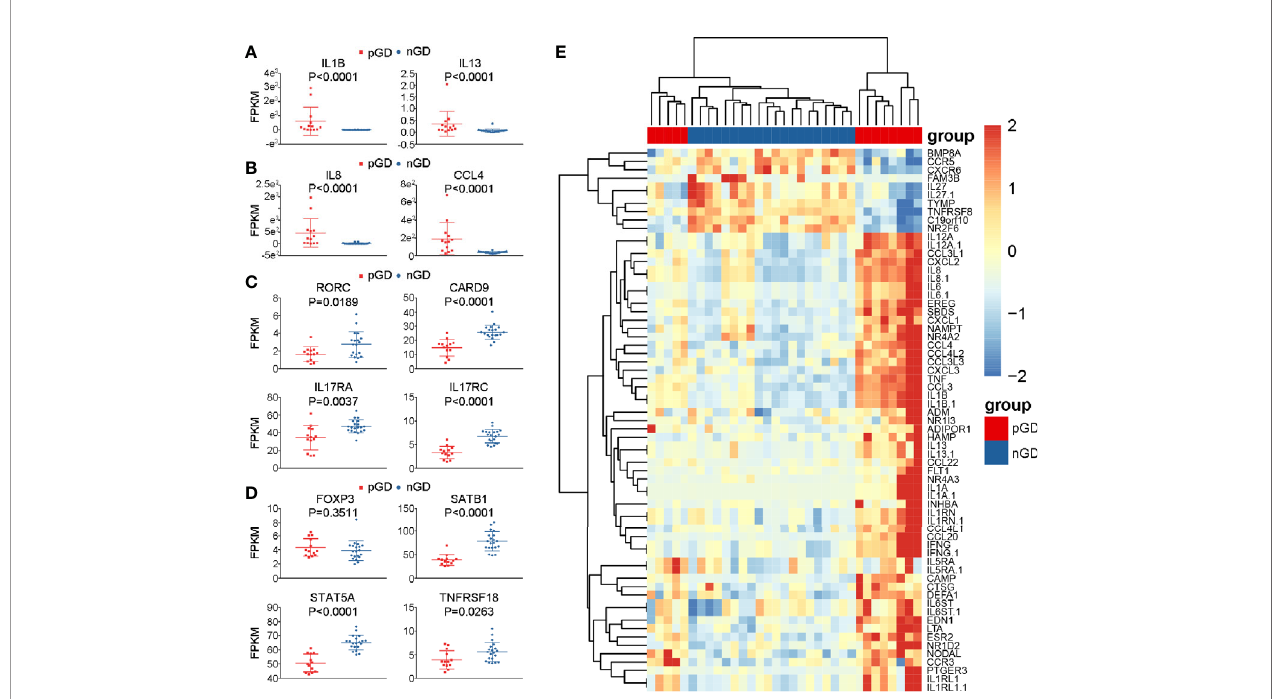
FIGURE 4 | Speci fi c genes expression in pGD compared with nGD patients. (A – D) Whisker plots indicated normalized gene expression associated with (A) in fl ammation (B) chemotaxis (C) Th17 cells (D) Treg cells between pGD (red, N = 13) and nGD (blue, N = 20) samples. Data were exhibited as mean with SD with individual values. (E) The hierarchical clustering of 13 pGD and 20 nGD patients by differentially expressed immune related genes. The heatmap showed, for each gene, the scaled expression in each patient. pGD, persistent Graves ’ disease; nGD, newly diagnosed Graves ’ disease; SD, standard deviation; FPKM, fragments per kilobase of exon per million fragments